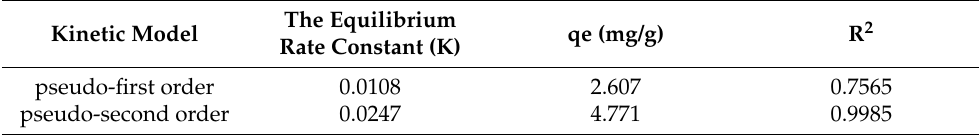
Table 5. Au(III) Adsorption kinetic models parameters using ZrO 2 -L 6